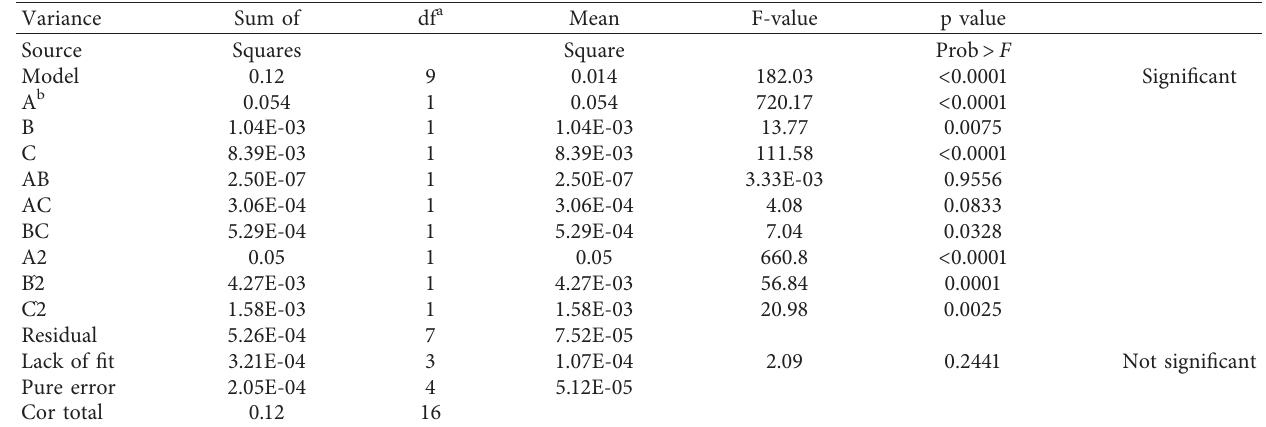
Table 3: Variance analysis of the reducing power